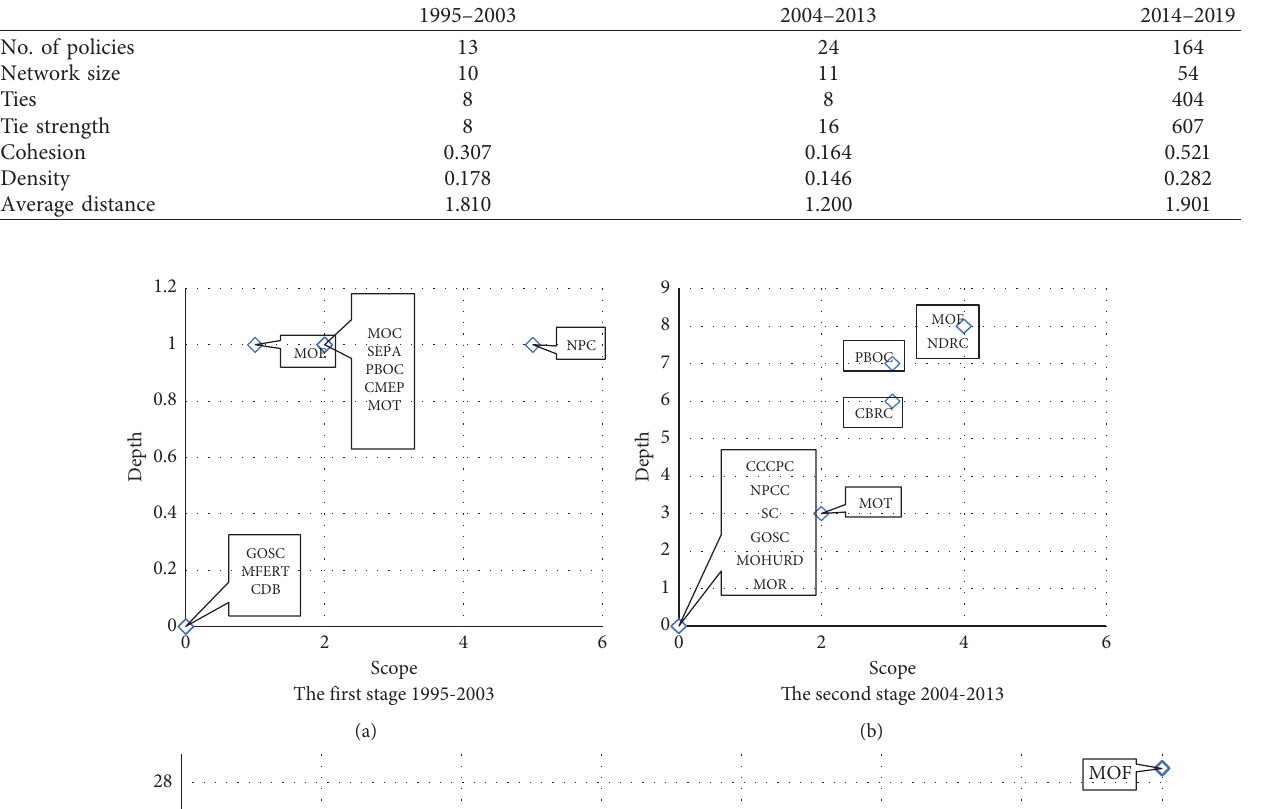
Table 4: PPPs policy entity network